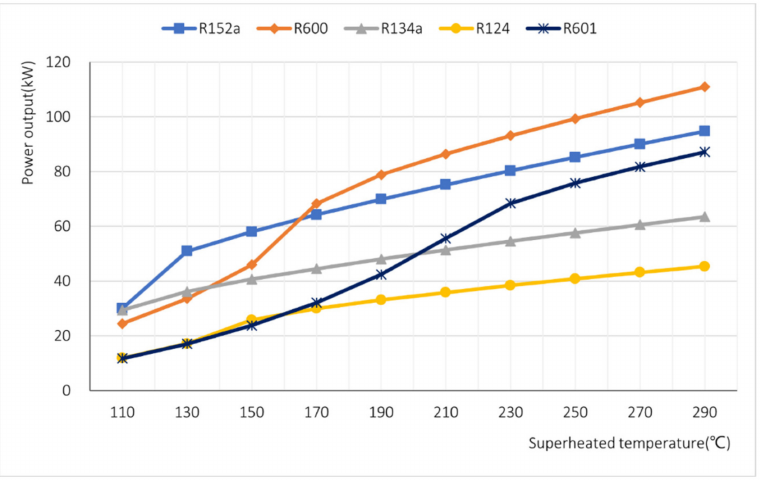
Figure 8. Power output of ORC under different working